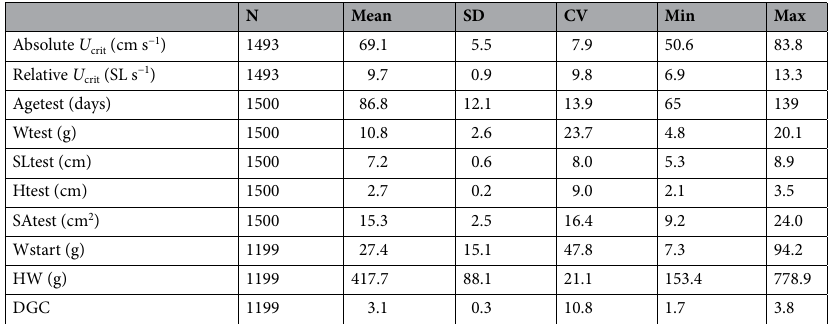
Table 1. Number of fish (N), mean, standard deviation (SD), coefficient of variation (CV) and minimum and maximum values for critical swimming speed ( U crit ), absolute and relative, age at swim testing (Agetest), body weight at swim testing (Wtest), standard length at swim testing (SLtest), and body height at swim testing (Htest), surface area at swim testing (SAtest), weight at cultivation start(Wstart), harvest weight (HW) and daily growth coefficient